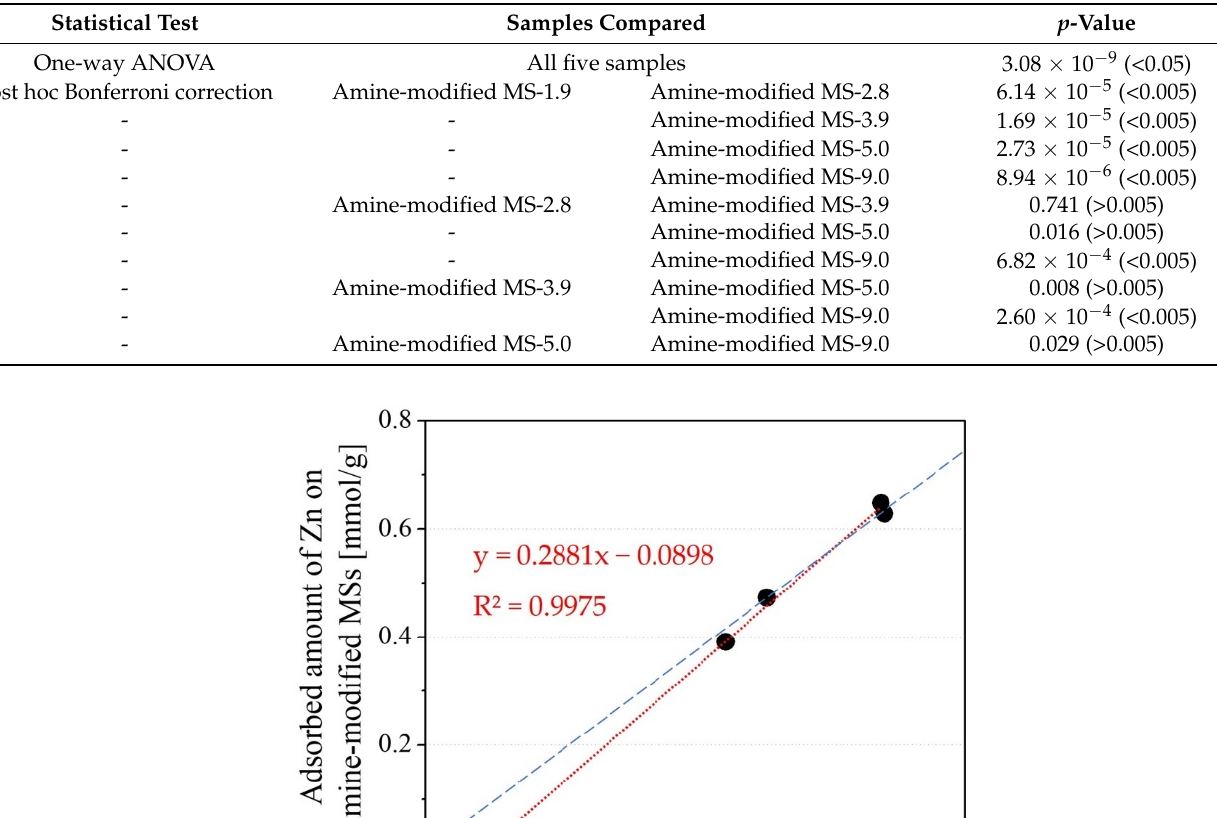
Table 1. List of p values obtained in statistical tests.